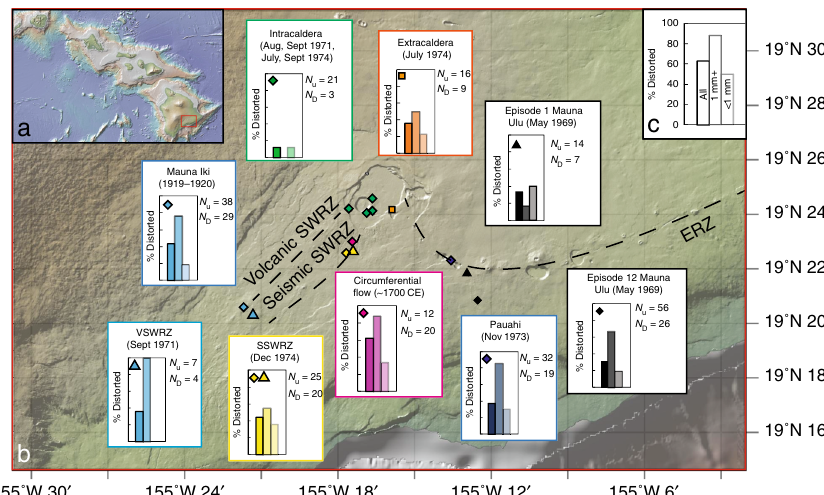
Fig. 1 Location of eruptions examined in this study. a Map of the Hawaiian Island Chain, with the red rectangle showing the location of K ī lauea Volcano on the island of Hawai ʻ i (expanded in part b ). b Expanded map of K ī lauea Volcano, with colored symbols showing the location of eruption deposits examined in this study (symbol colors and shapes are the same as those used in Fig. 5). The East Rift Zone (ERZ), and volcanic and seismic strand of the South West Rift Zone (VSWRZ and SSWRZ, respectively) are shown in black dashed lines. c Schematic histogram representing the proportion of distorted grains in three categories (all grains, grains >1 mm and <1 mm based on sieved size fractions). For each eruption site, a colored histogram following this schematic shows the proportion of distorted grains in each size category. The number of distorted ( N D ) and undistorted ( N U ) grains is also shown, along with the symbol used on the basemap. Basemap from GEOMAPP APP (see ref. 83 ; http://www.geomapapp.org), showing the topography of K ī lauea before the onset of the 2018 summit